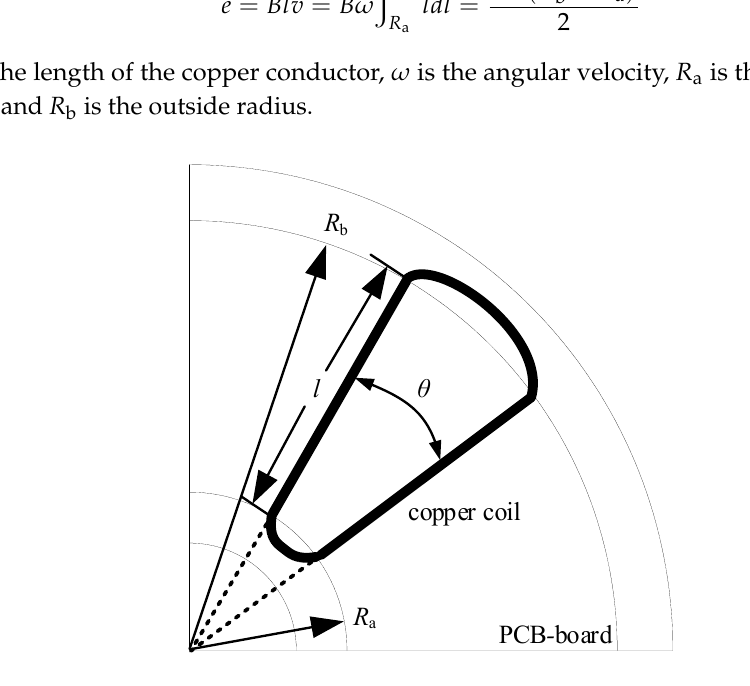
Figure 4. DDPMIM winding PCB.